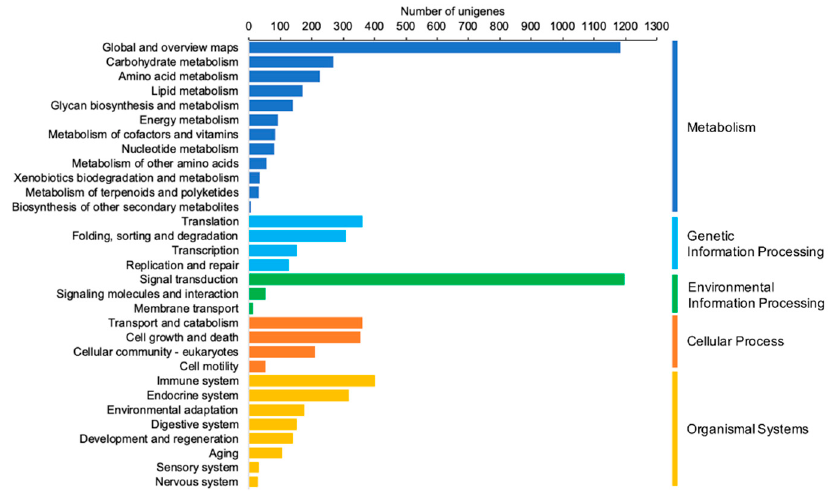
Figure 4. Distribution of pathways associated with the unigenes from the Z. subfasciatus transcriptome compared with the Kyoto Encyclopedia of Genes and Genomes (KEGG) database.